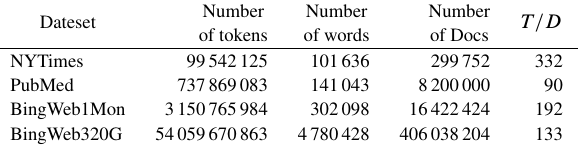
Table 3 Brief description of four datasets used in